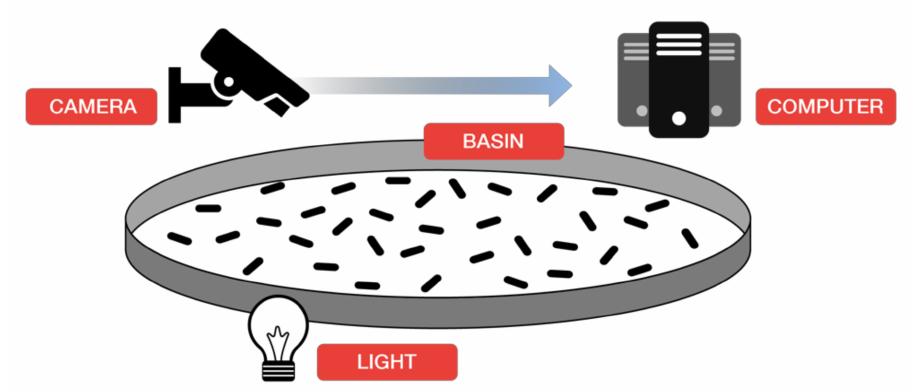
Figure 26. Illustrates the image acquisition of capturing the larvae image from hatcheries.